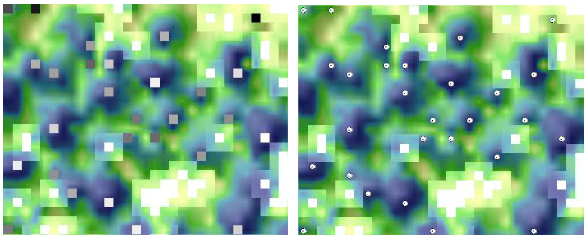
Figure 11. CHM overlaid with the local maxima (left) and the local maxima to points overlaid in the CHM